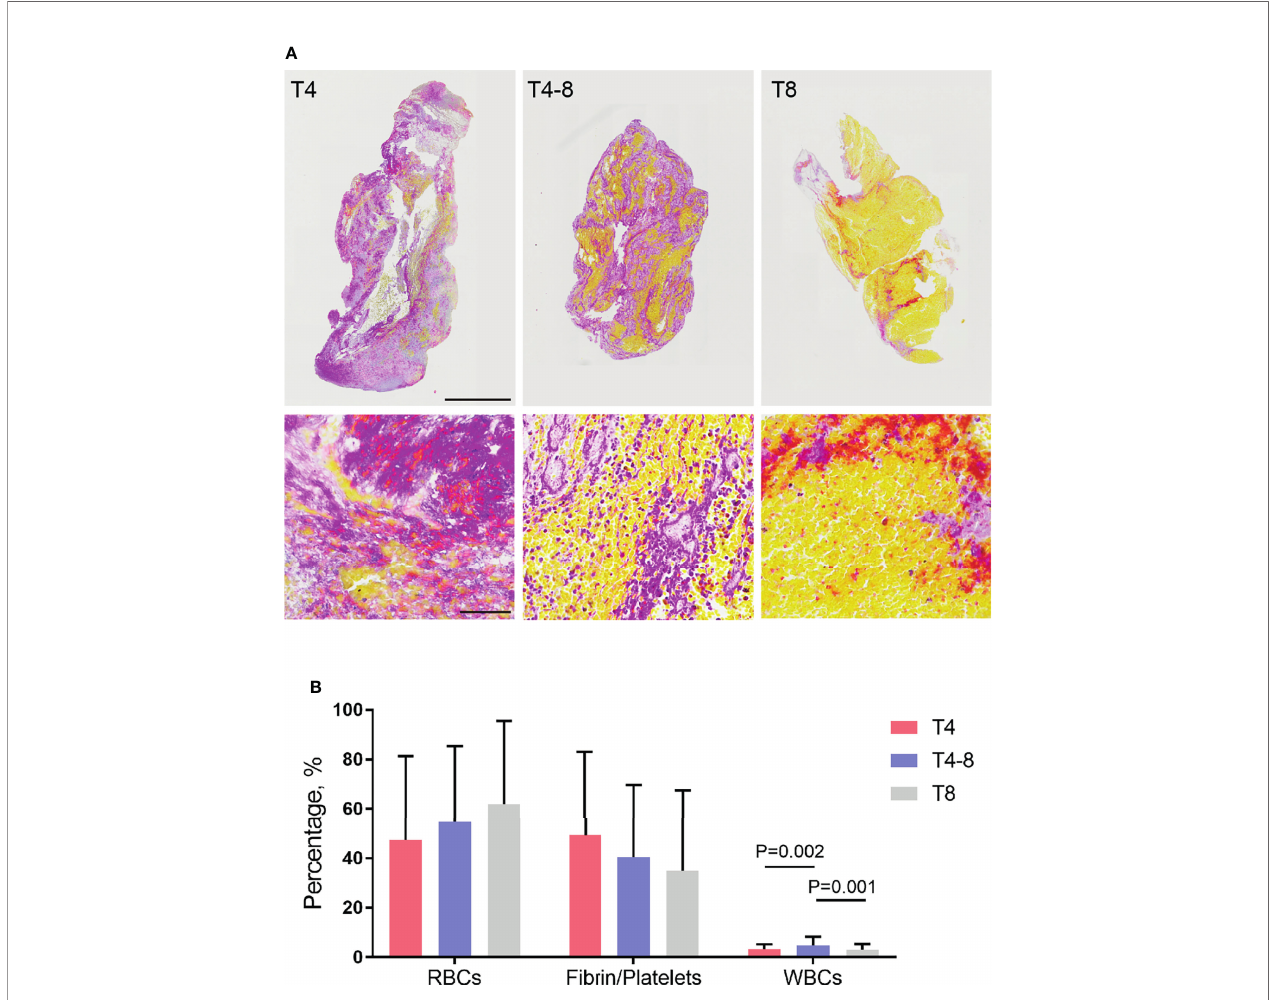
FIGURE 1 | Red blood cells (RBCs), fi brin/platelets, andwhite blood cells (WBCs)in thrombiin relation to the differentdurationsof time to reperfusion. (A) Representative image of thrombi sectionscomparing<4 h (T4), 4 – 8 h (T4 – 8), and >8 h (T8) time to reperfusion.Martius Scarlett Blue staining was used to detect RBCs (yellow), fi brin/ platelets (red or purple),and WBCs (blue).Low-magni fi cation scale bar = 1 mm; high-magni fi cation scalebar = 60 m m. (B) Box plot indicating thrombus composition changes with different times to reperfusion.The percentage of each component (RBCs, fi brin/platelets, and WBCs) relative to the wholethrombuswas